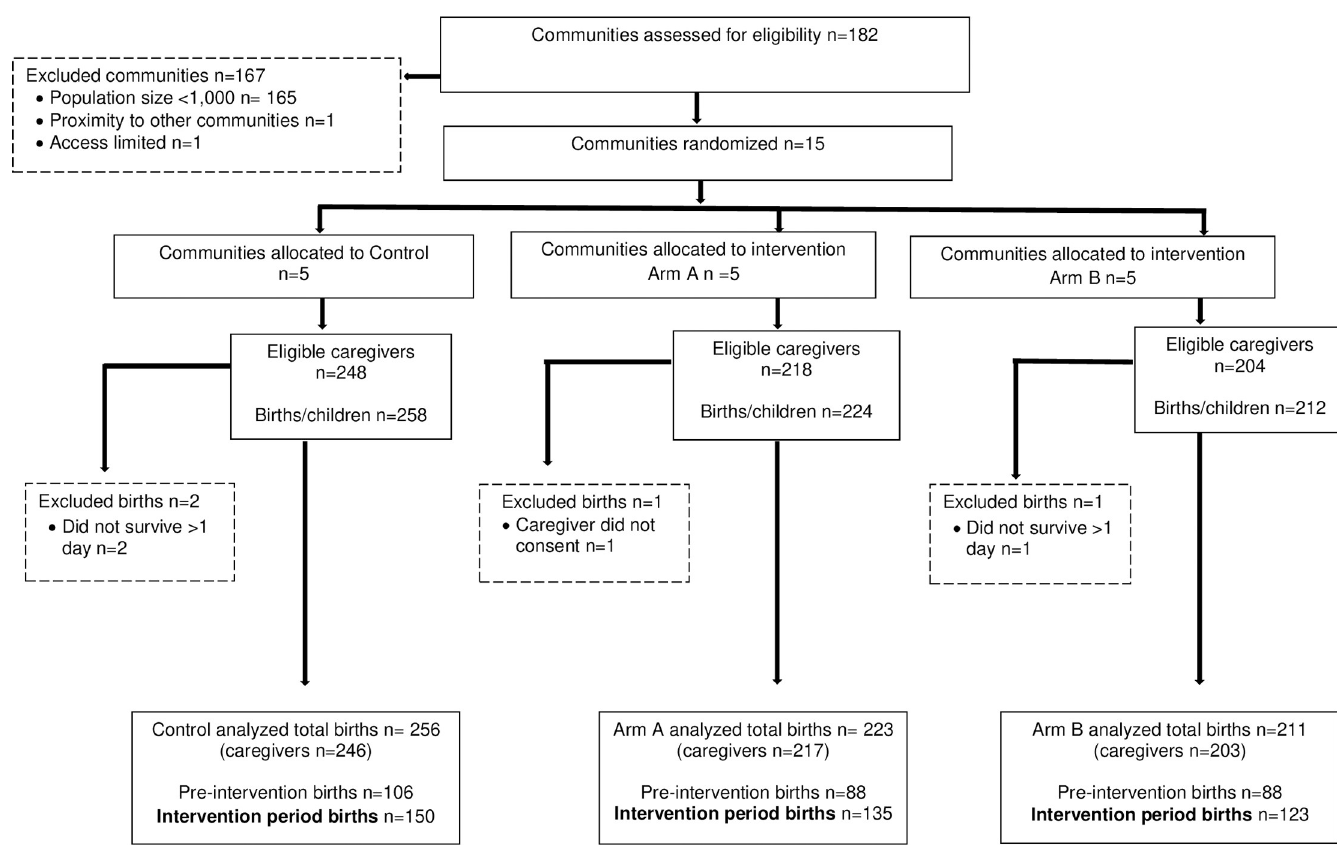
Fig 1. GEVaP study population